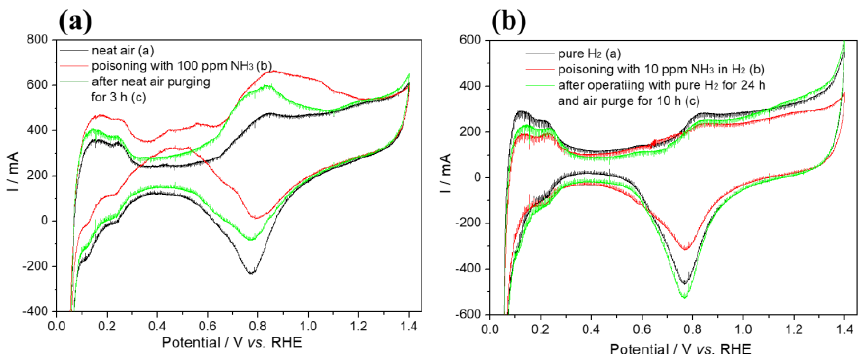
Figure 9. CV curves before and after poisoning with NH 3 in air ( a ) and in fuel ( b ). Table 2. The ECSAs before and after poisoning with NH 3 in air and The CV results poisoning with 10 ppm NH 3 in H 2 for 100 h (curve b) and then dis- charging with pure H 2 for 24 h and purging with air for 10 h (curve c) are shown in Figure 9b, as well as the one tested with pure H 2 (reference curve a). It can be seen in curve b that the H-desorption peaks in the range of 0.1 to 0.3 V decrease after the introduction of NH 3 , and due to the strong adsorption of NH 3 on Pt, the EAS of Pt is blocked by NH 3 , which in turn suppresses the HOR, leading to a decrease in cell performance. Furthermore, there exists a reduced oxidation peak of Pt at 0.85 V in curve b. This peak could be caused by the reduction of the EAS of Pt. Indeed, the reduction peak for PtO or PtO 2 at 0.7 V during the cathodic scan became weaker, because less Pt oxides were generated during the pre- vious anodic scan. After being discharged with pure H 2 and purged with neat air, curve c